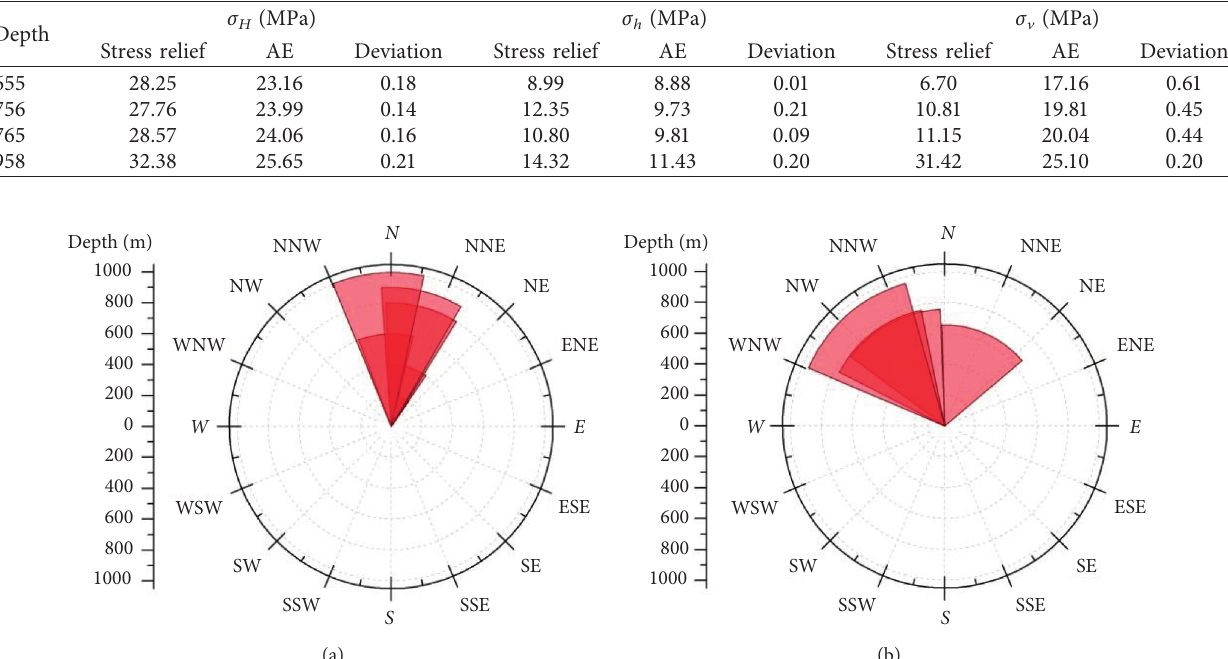
Figure 9: Azimuth of maximum principal stress. (a) Azimuth measured by AE method and (b) azimuth measured by stress relief